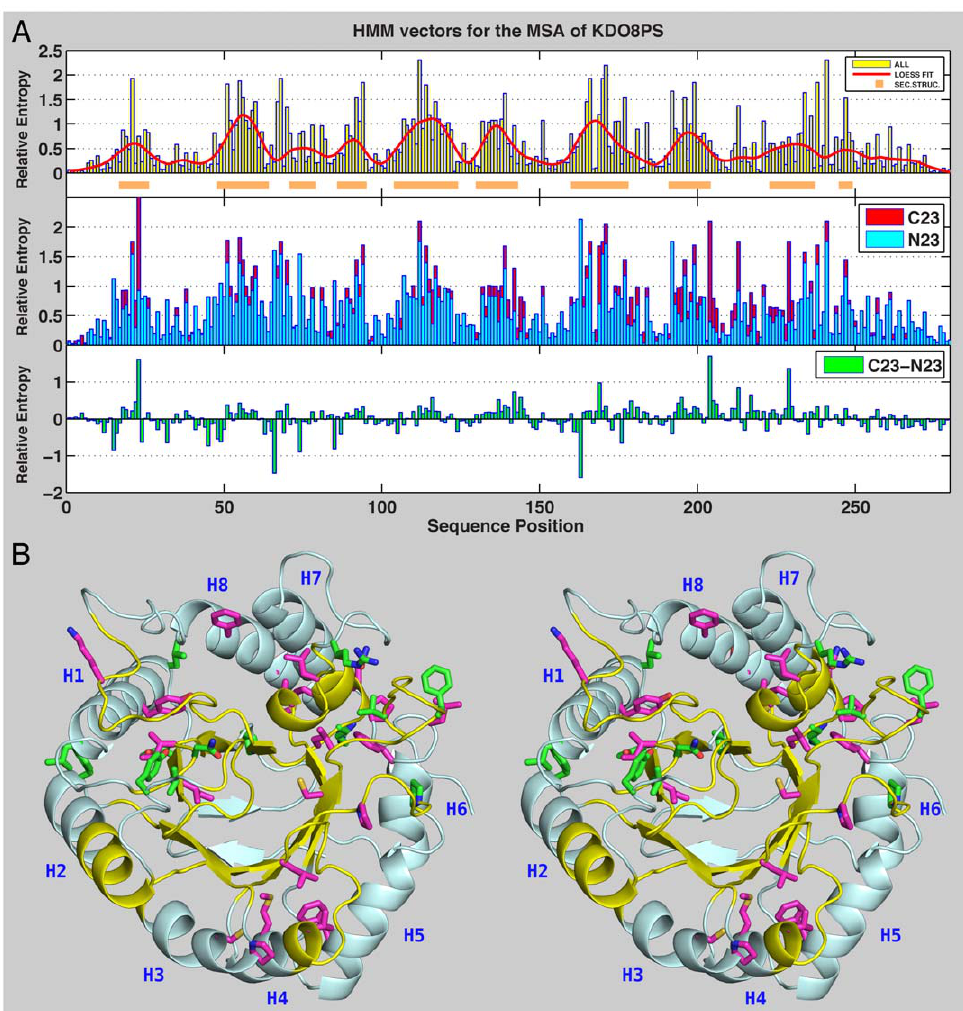
Figure 1. HMM histograms of metallo and non-metallo KDO8PSs. A. 1 st inset, HMM vector for all KDO8PSs with superimposed Loess fit (calculated with a span of 20 residues). Regions of the histogram higher than the mean are highlighted with an orange bar below the sequence. 2 nd inset, HMM vectors for the C23 and N23 sub-families of KDO8PS. 3 rd inset, difference between the HMM vectors of the C23 and N23 sub-families. B. Stereo view of a monomer of Nm. KDO8PS shown here as a ribbon drawing. The regions of the structure corresponding to the orange bars in the 1 st inset of Panel A are colored in yellow. Residues corresponding to positions with values . 2 s in the difference histogram of panel A are shown as sticks with green carbon atoms. Residues corresponding to positions with values . 2 s for the difference between C23 and N23 KDO8PSs in the correlation between stability and amino acid usage (last inset in Figure 2B) are shown as sticks with magenta carbon atoms. Helices are labeled (H1 to H8) according to their position in the amino acid sequence.